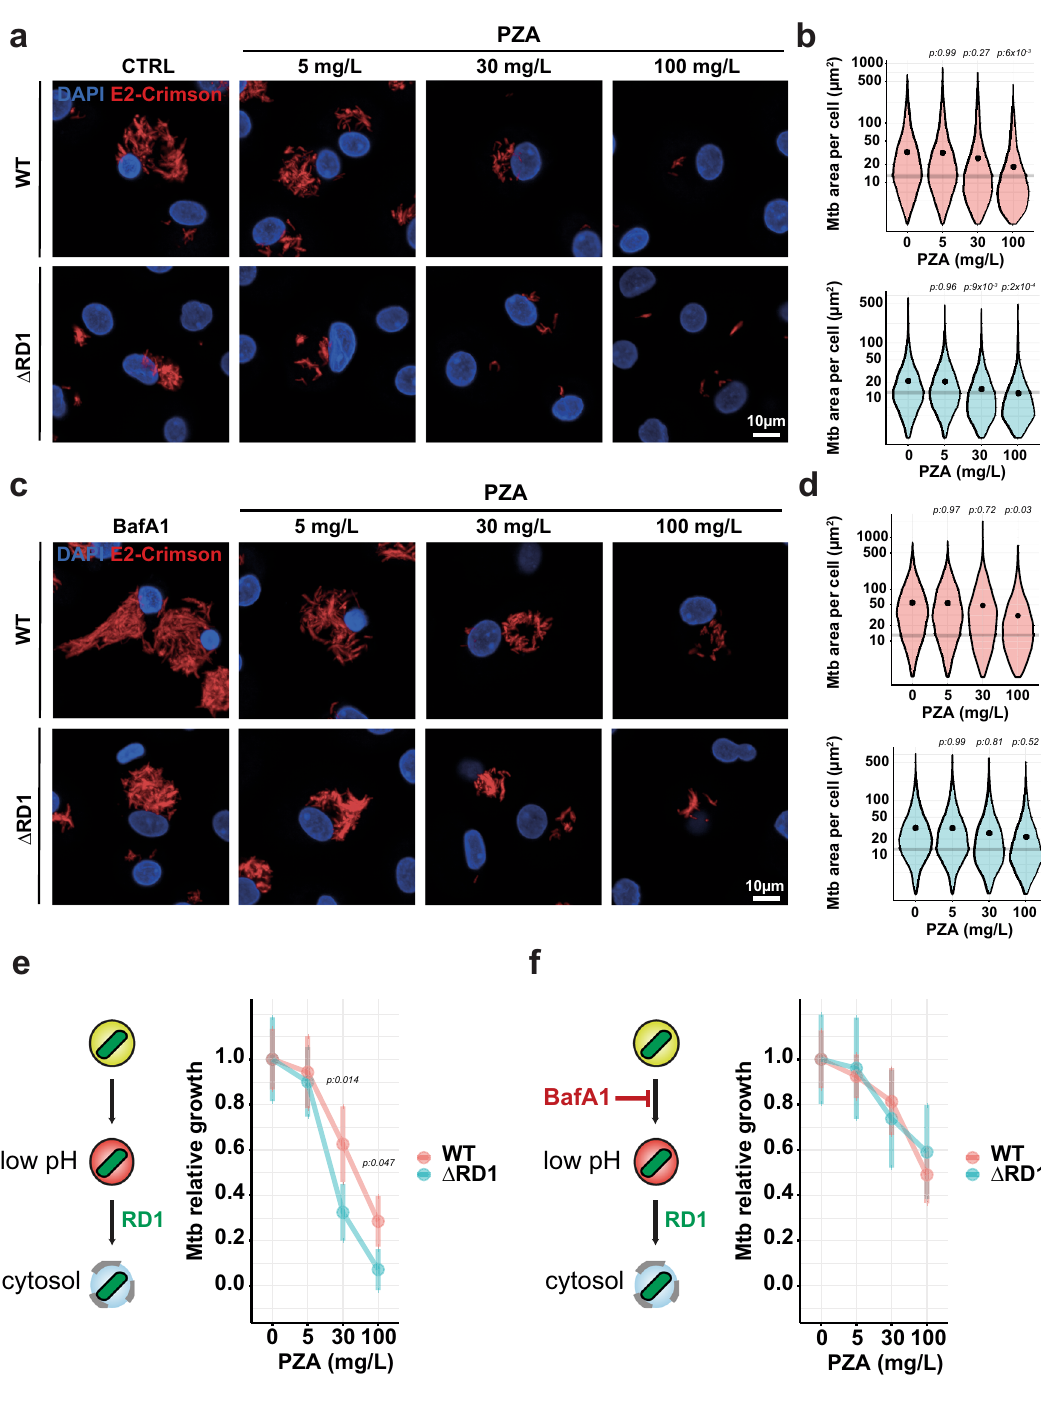
BafA1. The inhibition of endolysosomal acidi fi cation decreased PZA/POA levels associated with Mtb (Fig. 5e – g) (average mean intensity per positive bacteria of 138.84 ± 2.27 vs. 82.19 ± 1.75, p :2.2 × 10 − 14 ). Moreover, the percentage of positive bacteria upon BafA1 treatment decreased ~1.6-fold (Fig. 5h). Con fi rming these observations, distribution of the 15 N/ 14 N enrichment of the population signi fi cantly changed after BafA1 treatment (Fig.